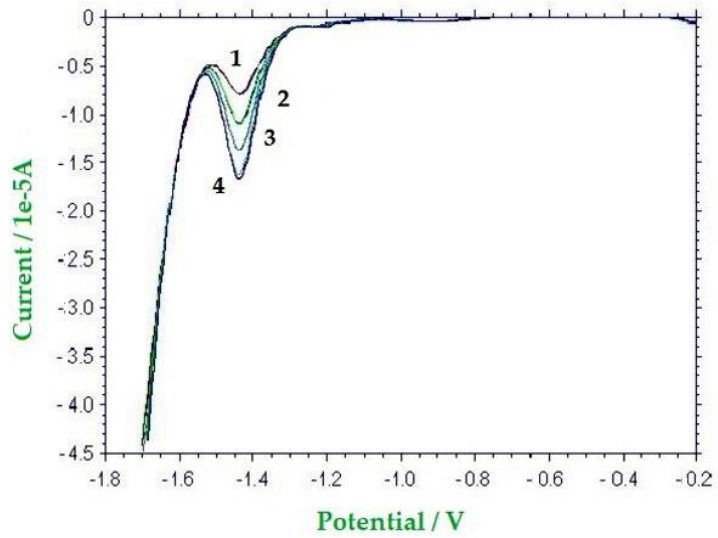
Figure 5. SW voltammograms of (1) a pure strawberry tree honey (50% w / w ) in a 0.1 mol dm −3 LiCl solution in water; (2) the same solution 1, after the addition of 0.75 mg of HMF, (3) the same solution 1 , after the addition of 1.50 mg of HMF; (4) the same solution 1, after the addition of 2.25 mg of HMF. WE: Hg; AE: Pt; RE: SCE. Potential scan rate: 0.10 V s −1 ; pulse height: 4 mV; frequency: 15 Hz; modulation amplitude: 25 mV.